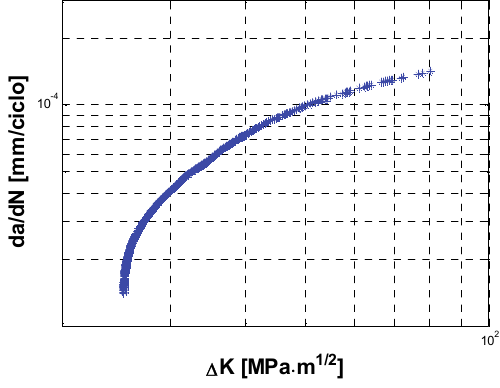
Figure 4: Crack growth rate curve from experimental